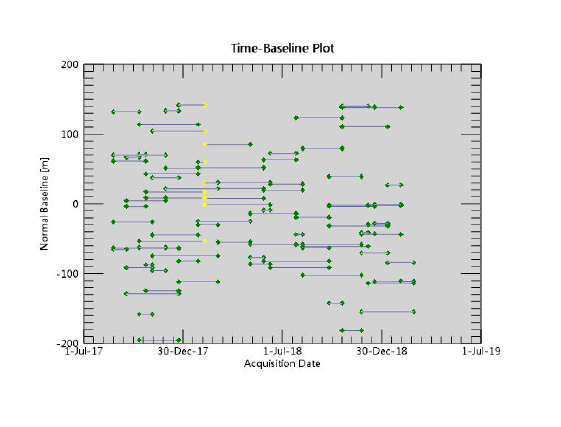
Figure 3. The time baseline of interferogram (2) Perform conventional interference processing on all sets of interference images, including: Interferogram Generation, Interferogram Flattening, Filter and Coherence Generation, Phase Unwrapping. The SAR image is first registered to the same coordinate space, and the two images are multiplied by complex conjugates. Then the SRTM3-DEM data is used to remove flat phase. In order to reduce the noise of the interferogram and increase the signal-to-noise ratio, the interferogram is subjected to Goldstein filtering. For phase unwrapping, a minimum cost flow (MCF) based on Delaunany triangulation is used, and the coherence threshold in the phase Figure 2. Interference pair combination unwrapping is set to 0.35 to suppress the influence of noise errors and low coherence points on the unwrapping effect. (3) After unwrapping, select GCP control points to remove residual constant phase and phase ramp in areas without residual terrain stripes, deformation stripes, and phase jumps. The singular value decomposition method was used to estimate the deformation rate and residual terrain of the high coherence points, and then the secondary unwrapping was performed